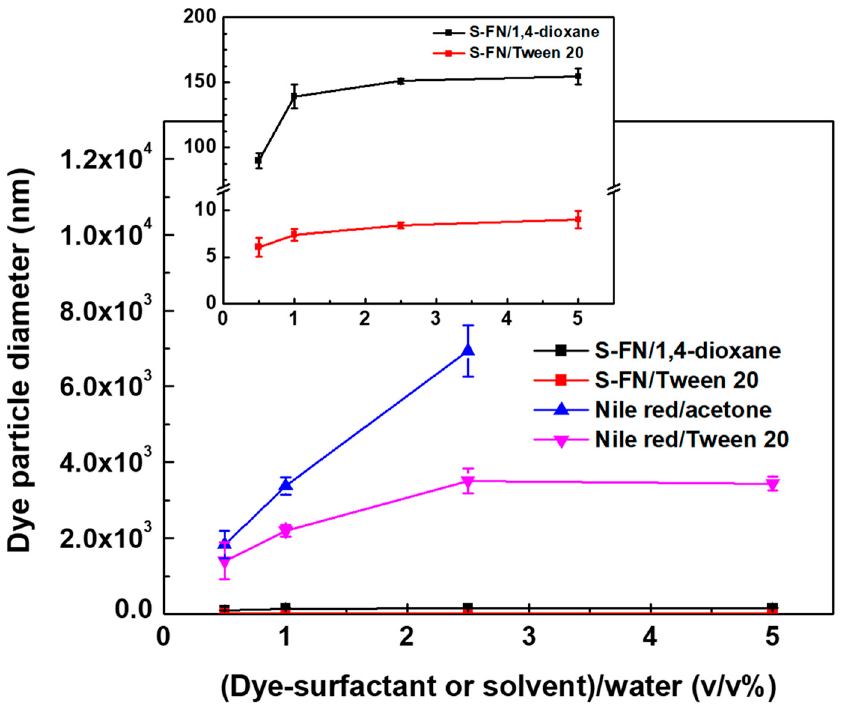
Figure 2. Size of dye particles with different dye and surfactant (or solvent) combinations at various concentrations in water (dye/surfactant or solvent = 1 g/L).